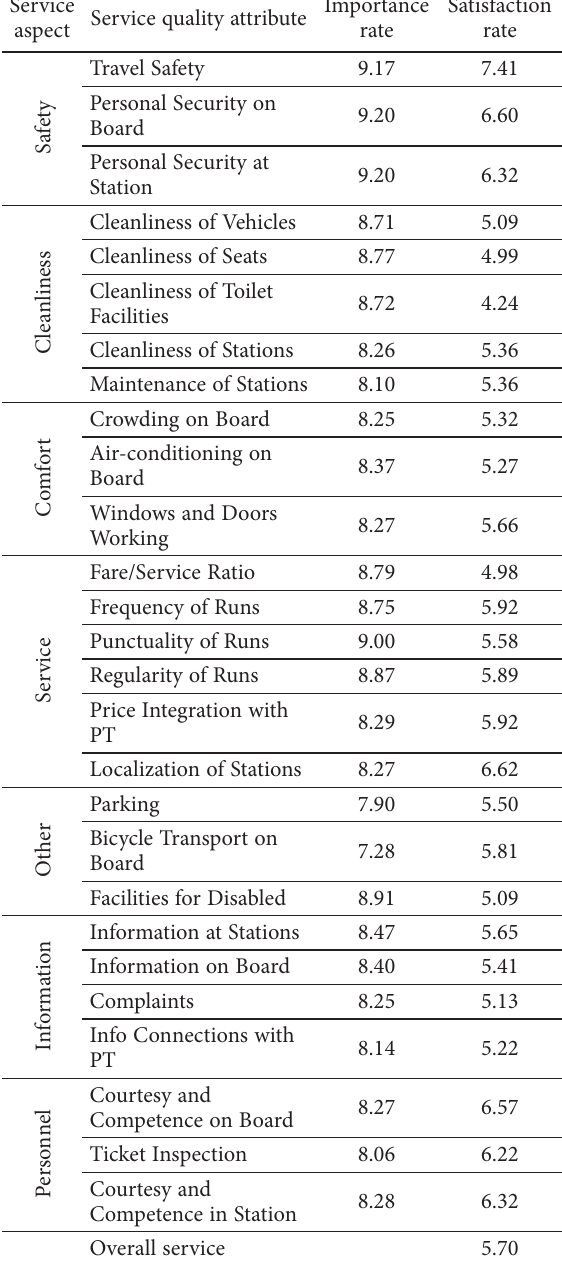
Table 2. Importance and Satisfaction